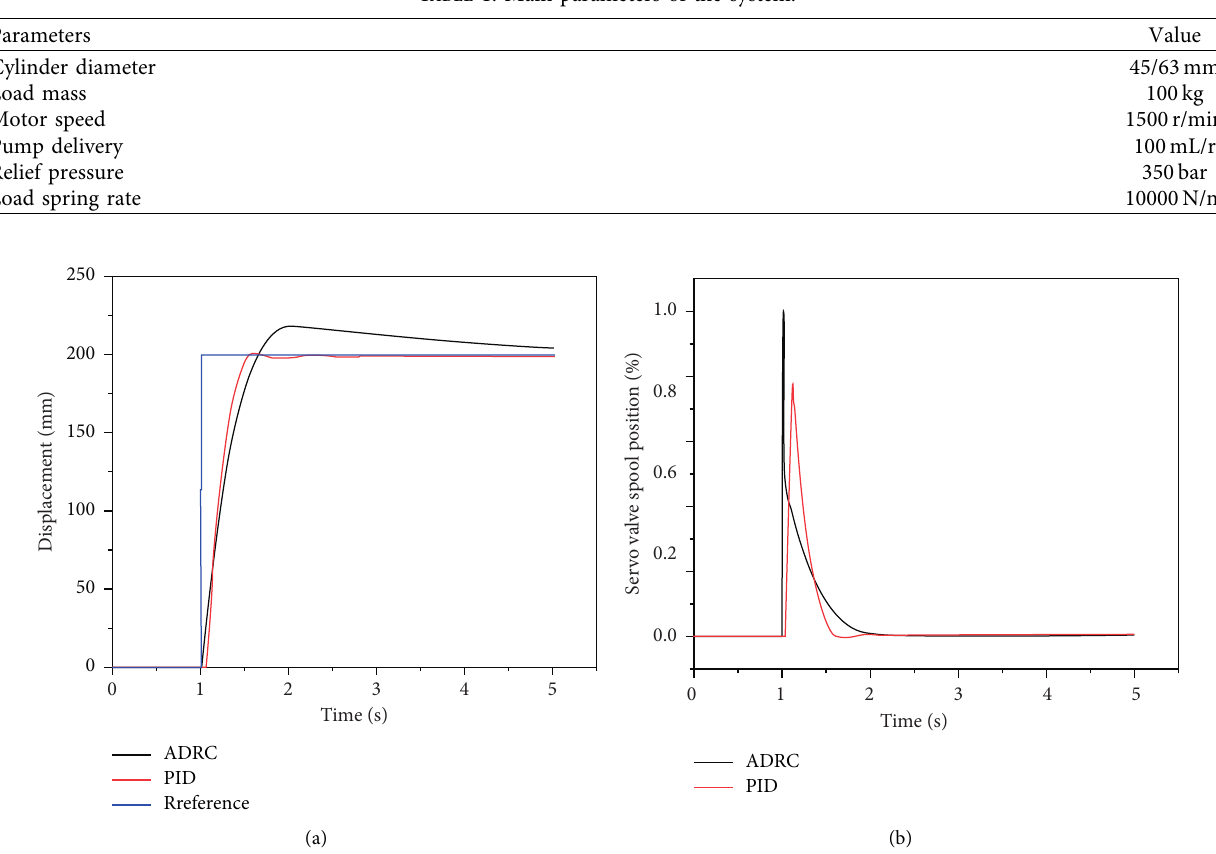
Table 1: Main parameters of the